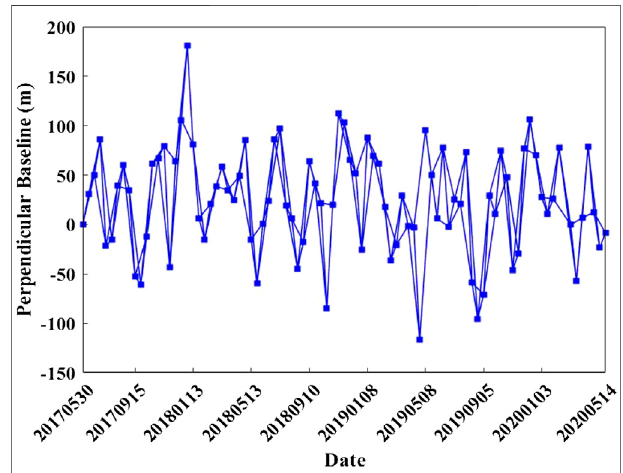
FIGURE 3 | The temporal and perpendicular baseline of the formed small baseline interferograms.